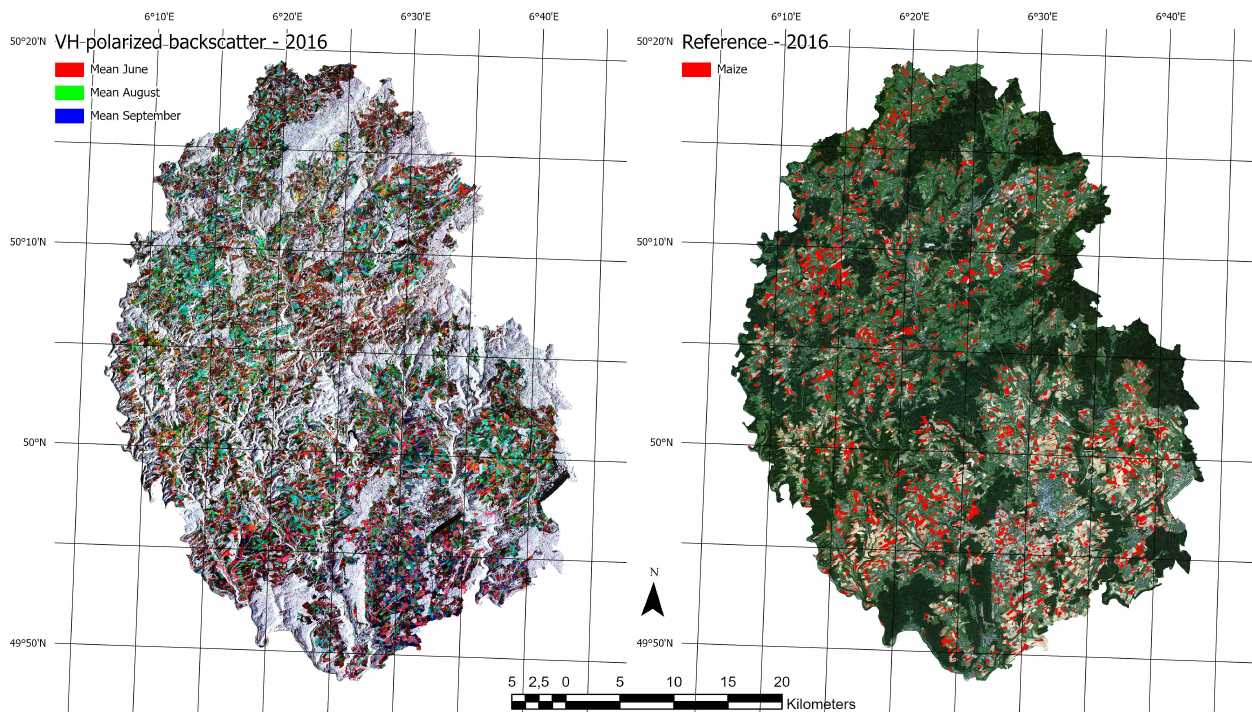
Figure 2. The figure shows an overview of input data. The left side shows an RGB composite of three different monthly means from the Sentinel-1 input data. The right side shows a rasterized version of all maize fields from the the InVeKos dataset with a RapidEye RGB composite in the background.